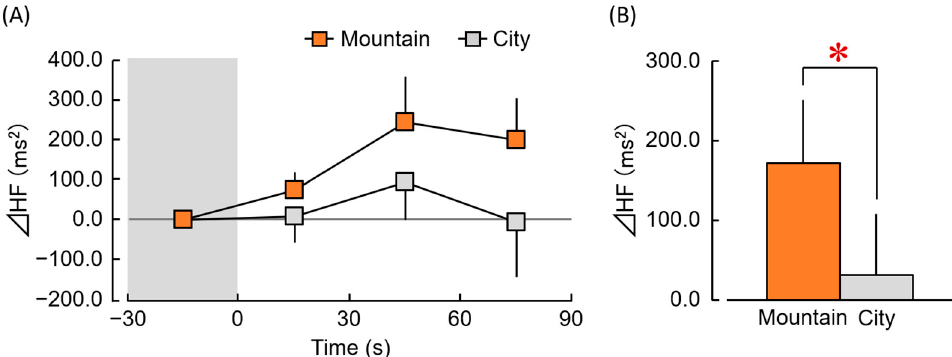
Figure 5. Changes in the high frequency (HF) of heart rate variability (HRV) for exposure to the mountain and city images. ( A ) Changes in the 30-s mean HF component over 90 s of exposure (difference from the mean value for 30 s before exposure). ( B ) Changes in HF during exposure to the mountain and city images for 90 s. ( n = 26, mean ± standard error). * p < 0.05 (mountain vs. city), paired t -test.